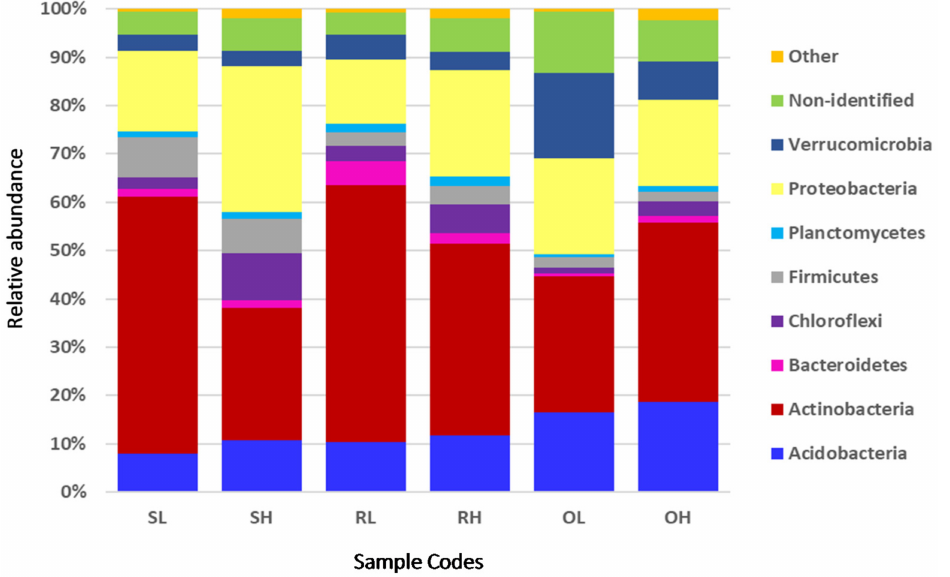
Figure 3. Relative abundance of bacterial phyla in the rhizosphere of Brachystegia boehmii sampled in three different soils under low and high fire frequencies. Sample codes follow Figure 1. Rare phyla (<1%) were grouped as